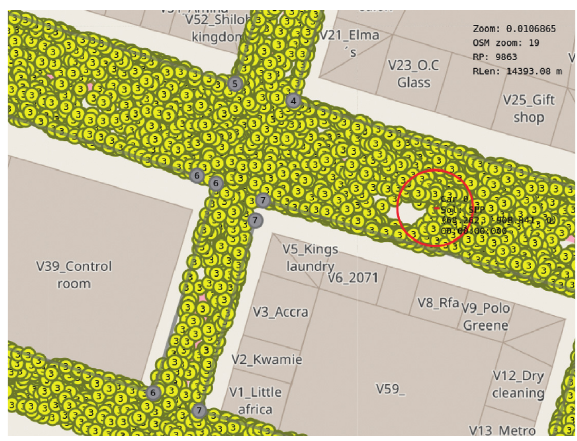
Figure 8: Part of a 14km long trajectory generated within the driving area from Figure 6.